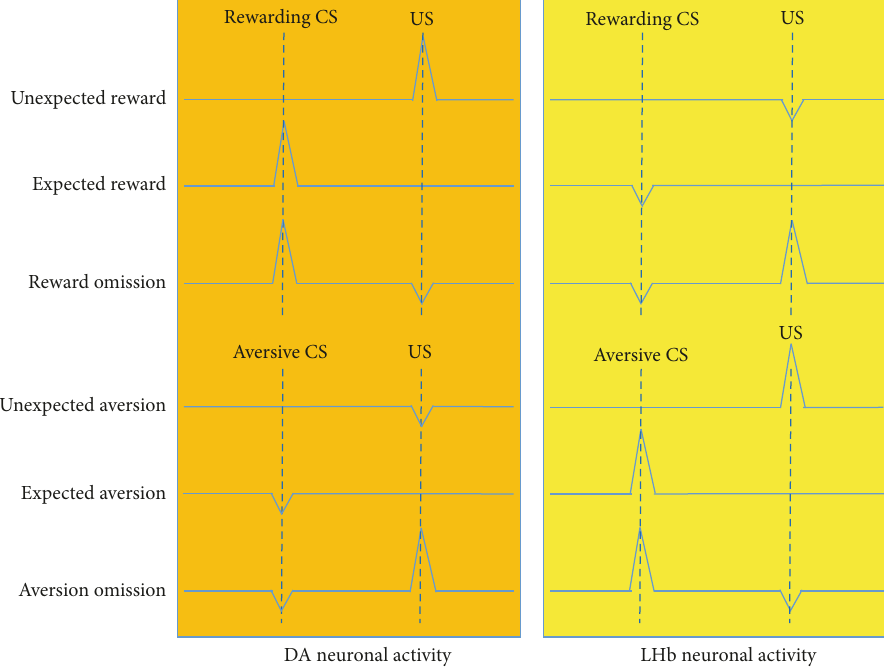
Figure 1: Schematic diagram of phasic activity of DA neurons (left orange part) and LHb neurons (right yellow part) given rewarding CS (upper) and nonrewarding/aversive CS (bottom). Each row denotes one situation of